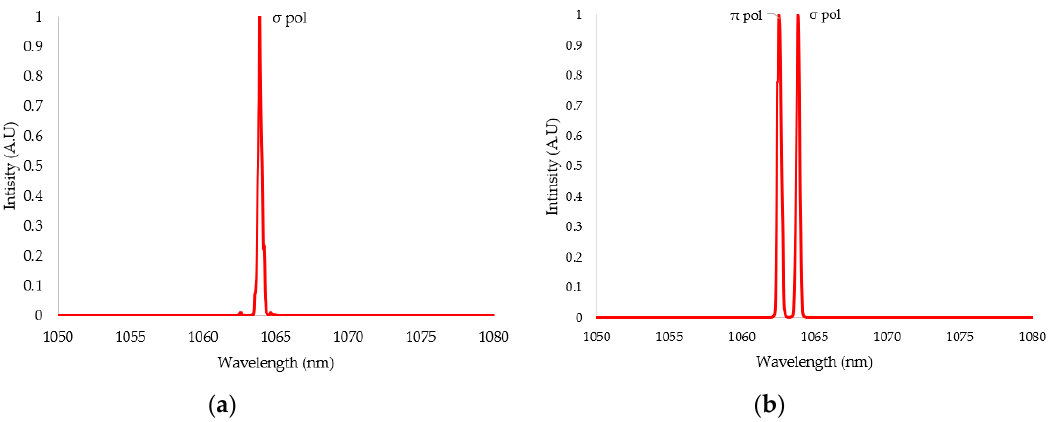
Figure 4. ( a ) and ( b ) are the single (1063.7 nm) and dual-wavelength normalized emission spectrum